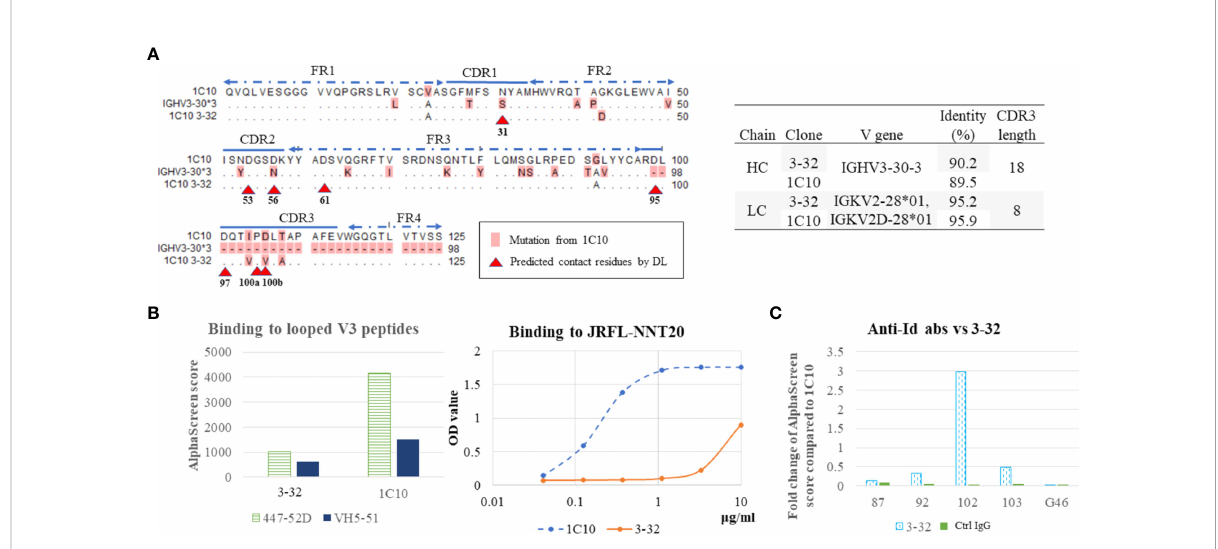
FIGURE 3 Antibody of 1C10 lineage bound weakly to V3 loops. Amino acid (AA) sequence alignment of heavy chain variable regions of 1C10, germline (IGHV3-30), and a sibling antibody of 1C10 lineage (3-32). The different AAs are highlighted as pink, and predicted contact residues detected by deep learning (DL) are indicated by red arrow heads. Gene usage of the two antibody clones was analyzed with the Basic Local Alignment Search Tool (BLAST) and results are in the table on the right (A) . Binding of 1C10 and 3-32 to two looped V3 mimotopes (447-52D and VH5-51) was tested by AlphaScreen, and binding to the linear V3 loop peptide (JRFL-NNT20) was assayed with ELISA (B) . Interaction between anti-Id antibodies and 3-32 were examined using AlphaScreen (C) .